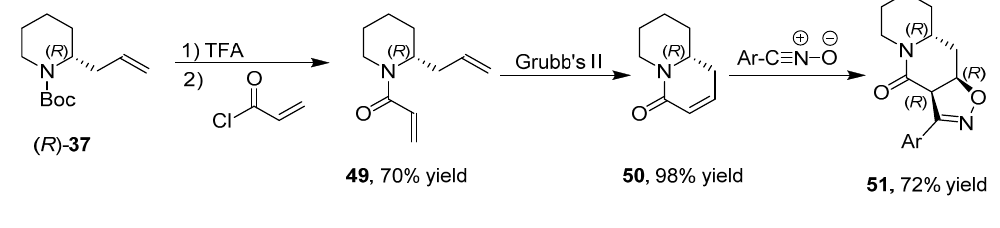
Scheme 16. Synthesis of derivative 51 .